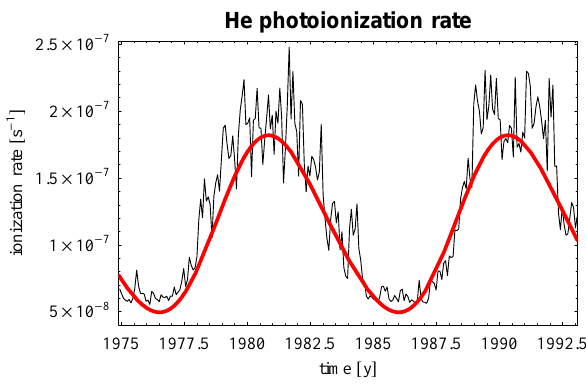
Fig. 1. Evolution of helium photoionization rate in time used in this study (red) shown in comparison to the actual instantaneous ionization rate inferred from the 10.7 cm